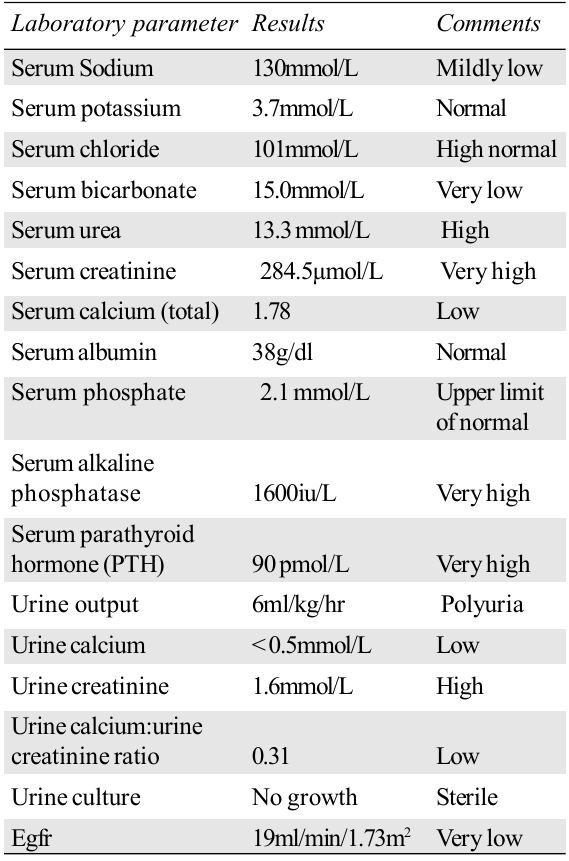
Table 1. Summary of laboratory findings Laboratory parameter